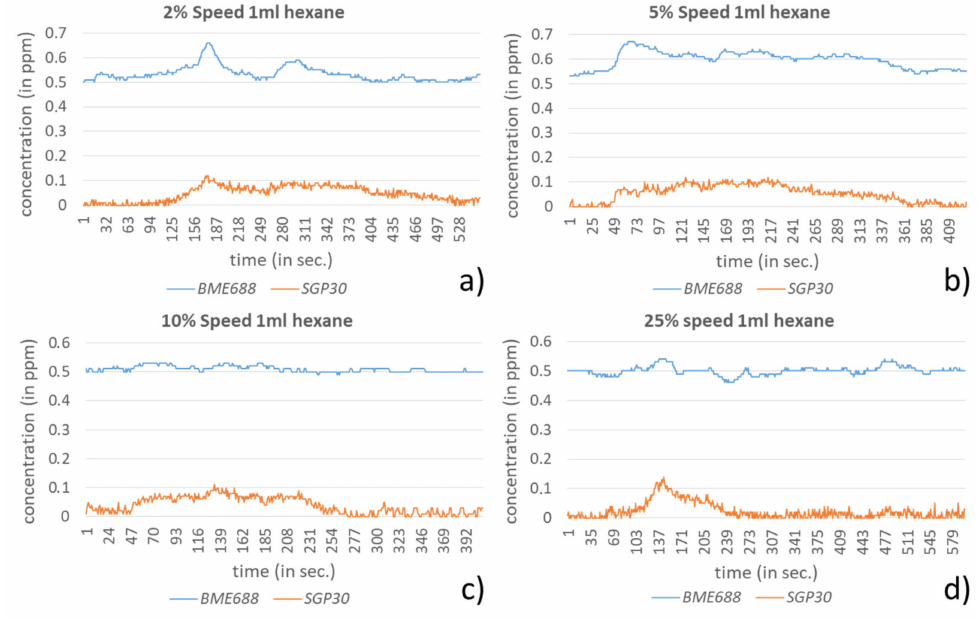
Figure 15. Results for the detection of 1 mL hexane during a pick and place procedure using TS60 in different speed levels,